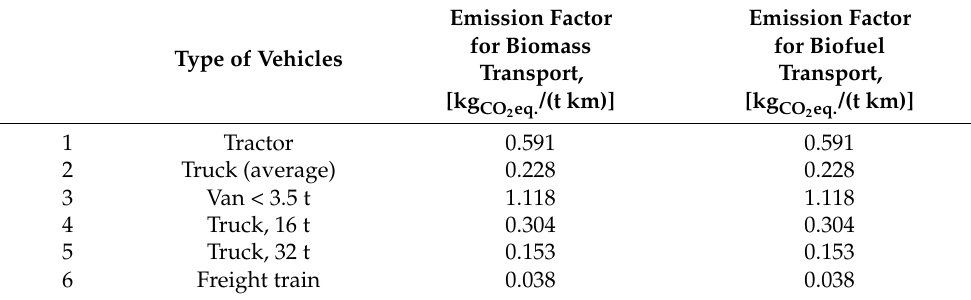
Table 8. Transport emission factor for different types of vehicles.